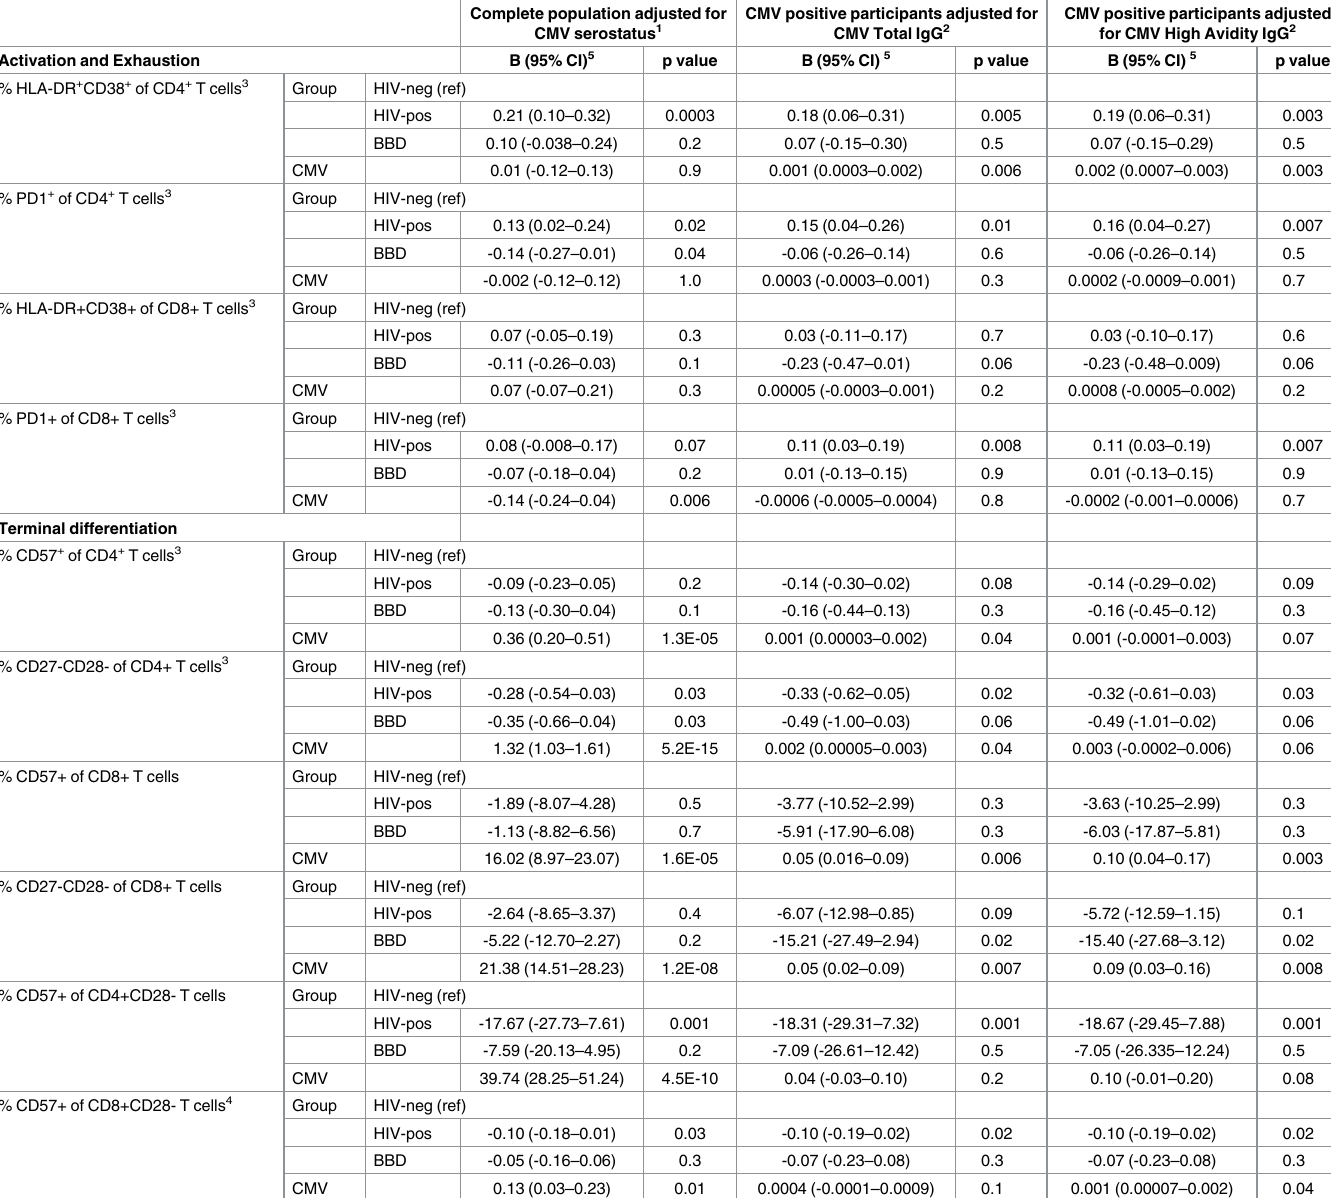
Table 3. Multivariable analyses of the association between HIV-1 infection, CMV serostatus, as well as CMV total and high avidity IgG titers, and T cell activation, exhaustion and terminal differentiation in HIV-positive and HIV-negative COBRA participants and blood bank donors. Completepopulation adjustedfor CMVpositiveparticipantsadjustedfor CMVpositiveparticipantsadjusted CMVserostatus 1 CMVTotalIgG 2 forCMVHighAvidityIgG